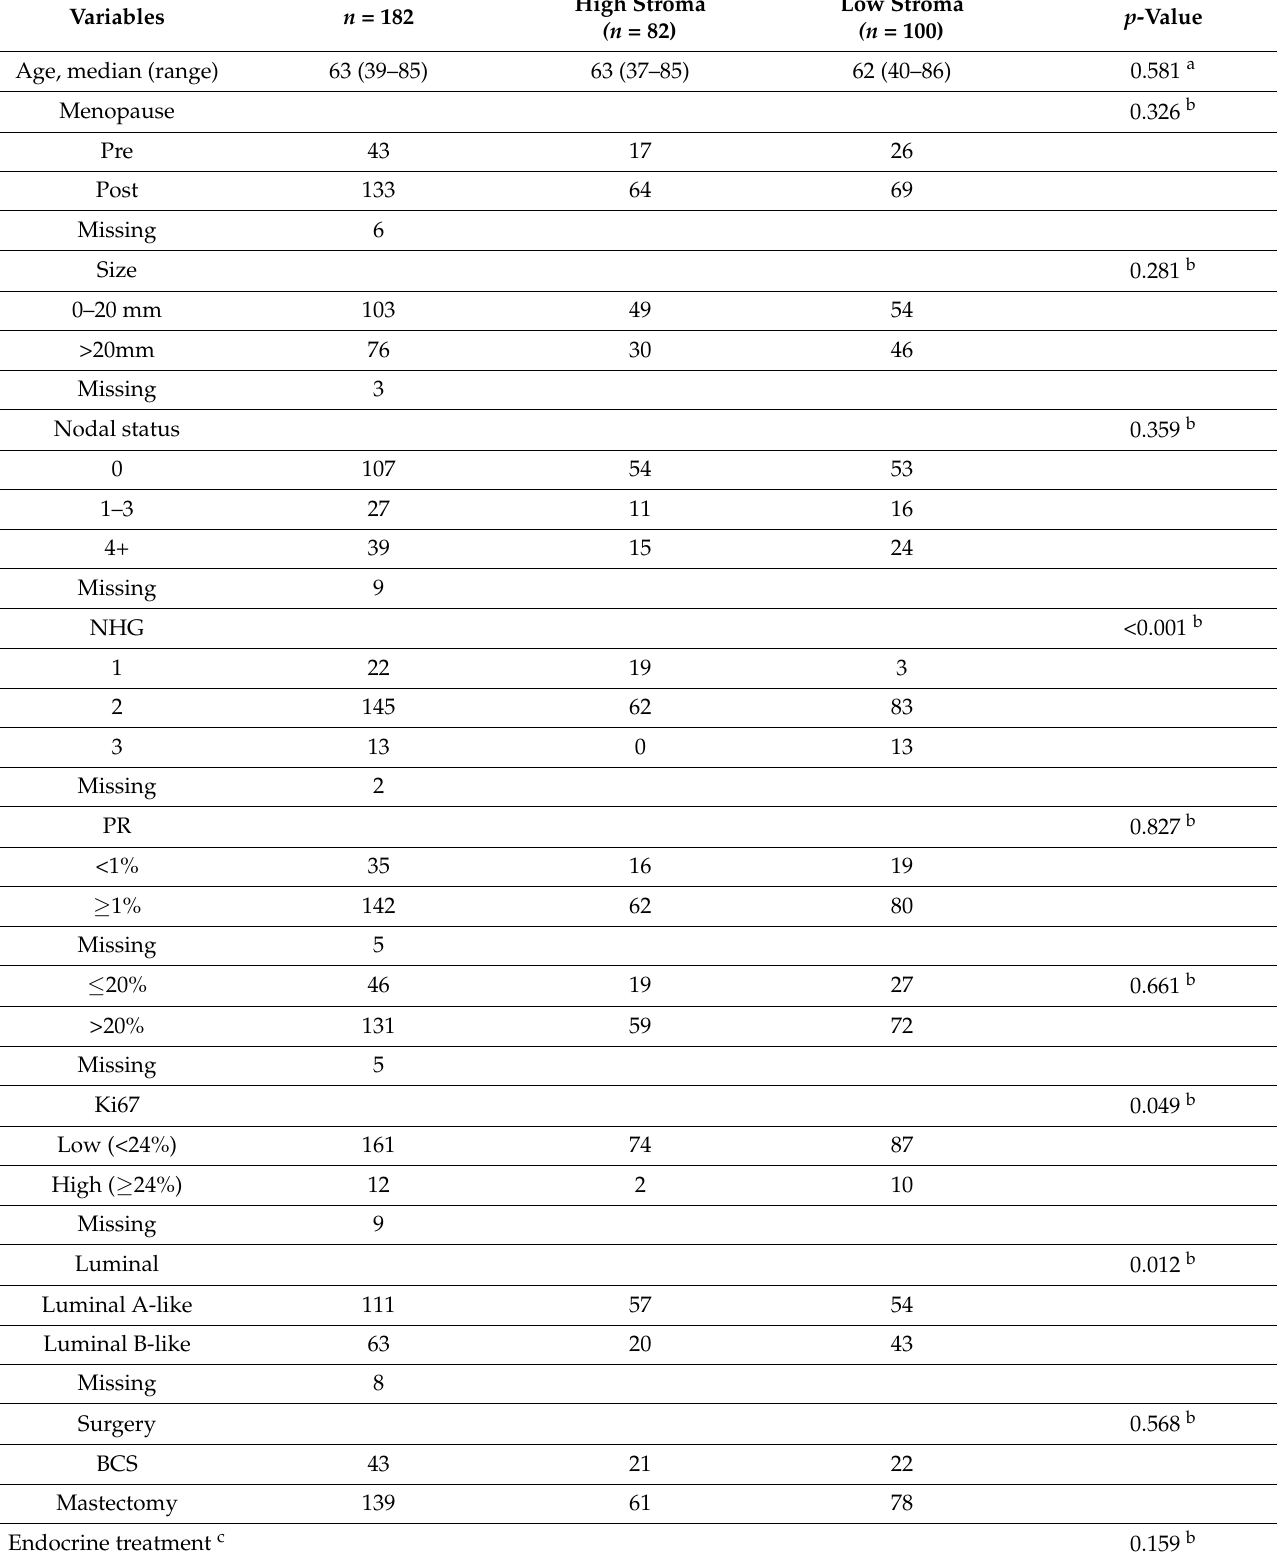
Table 1. Patient and tumor characteristics in relation to intratumoral stromal